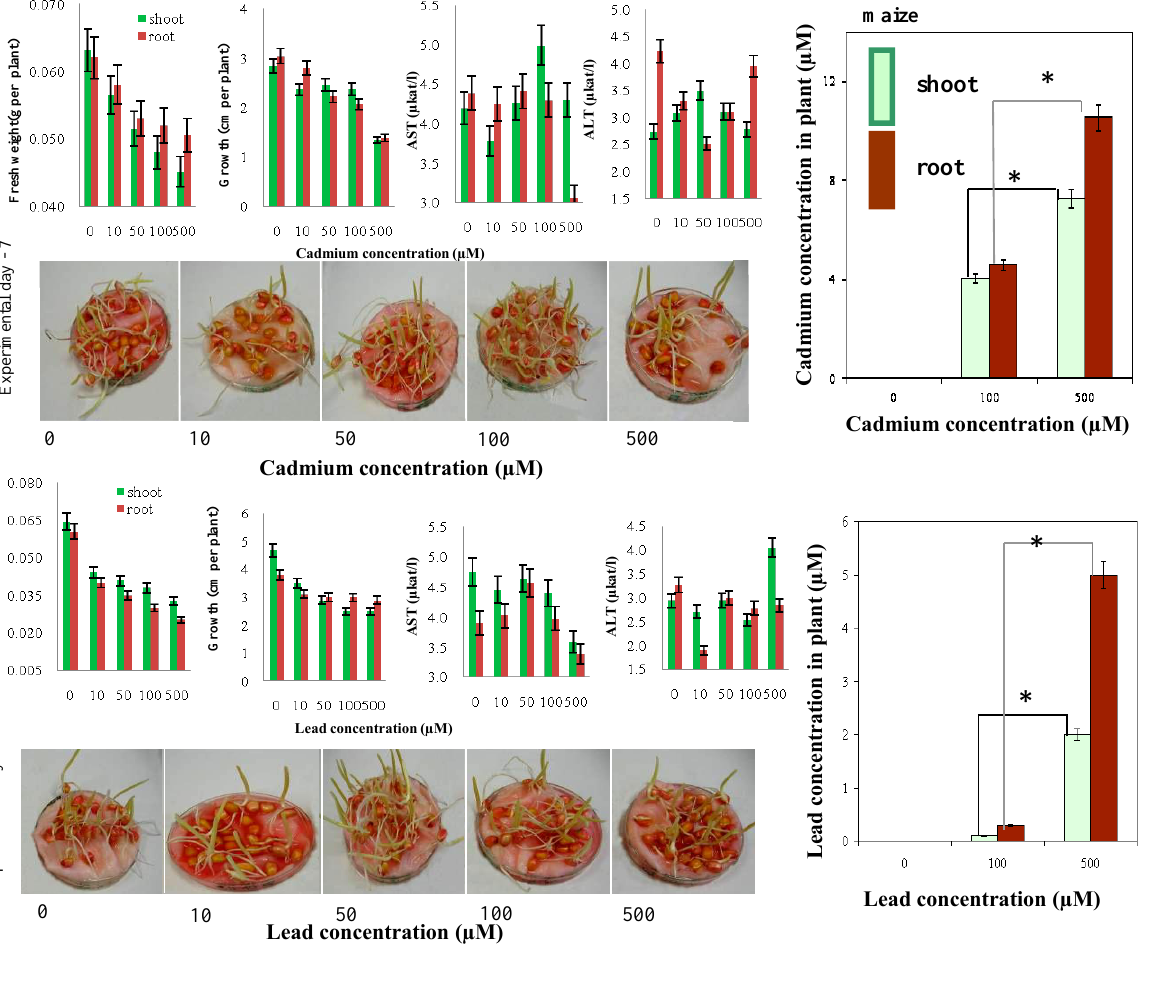
Figure 8. Maize seedlings. Changes in fresh weight, growth, AST and ALT activities in maize seedlings treated with (A) cadmium(II) ions and/or (B) lead(II) ions. Content of (C) cadmium(II) ions and /or (D) lead(II) ions in shoots and roots of the treated